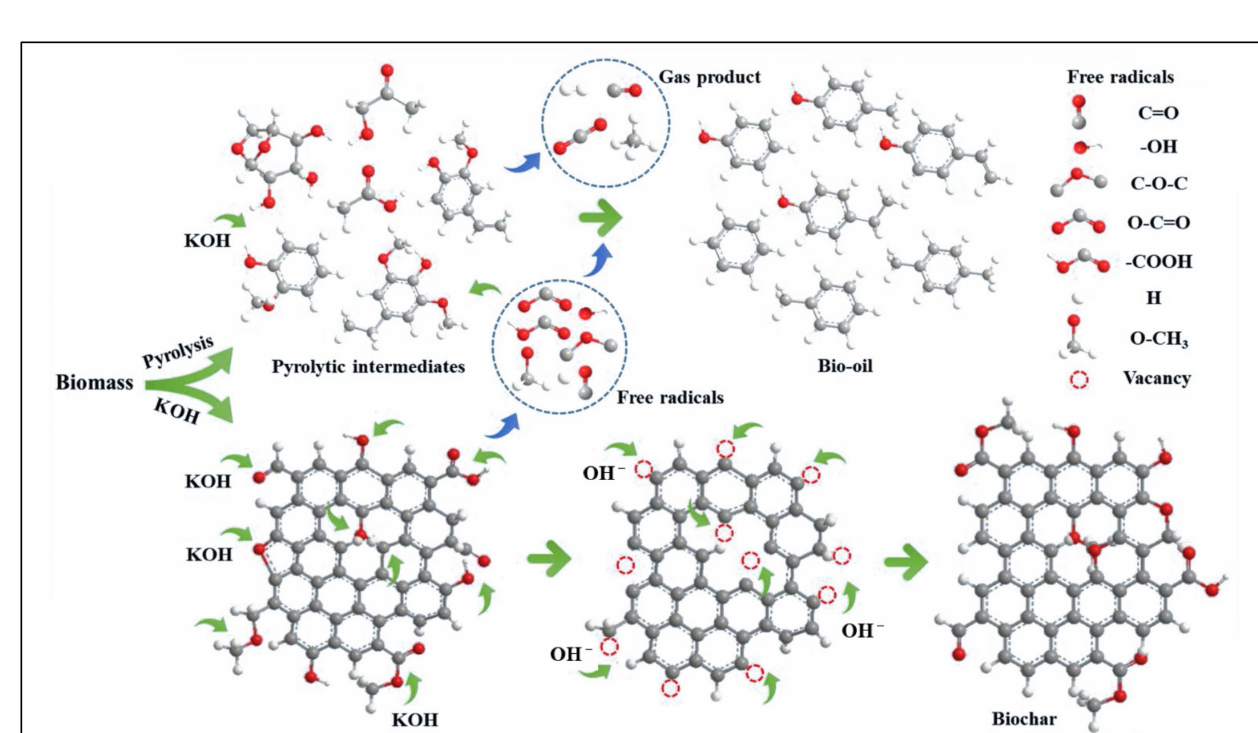
Figure 1. KOH activation mechanism of AC from LB